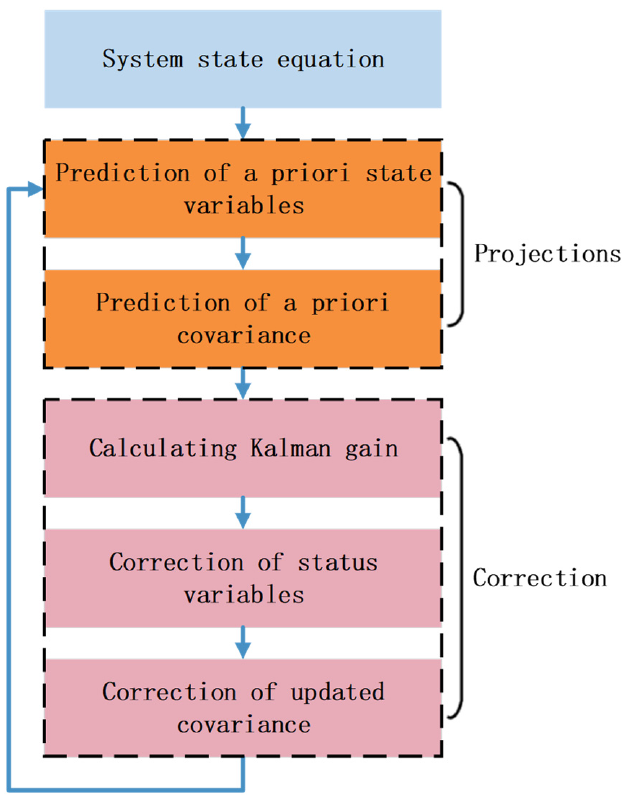
Figure 9. The basic process of Kalman fi ltering.